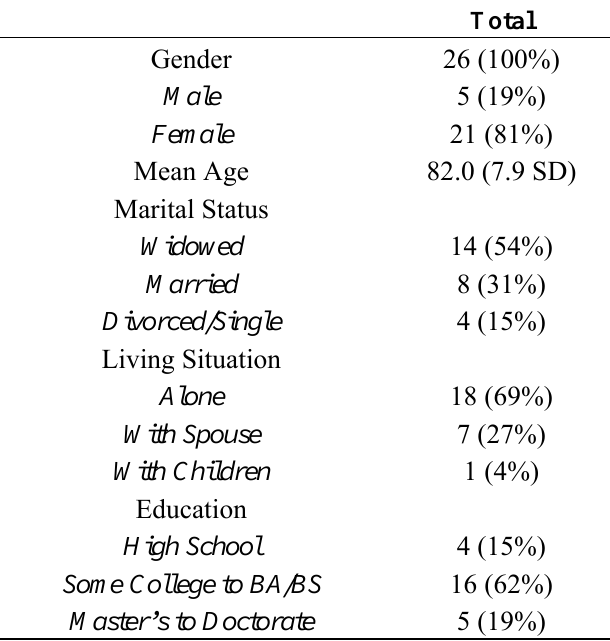
Table 2. Demographics and Smith-Kettlewell Reading Test (SK Read)